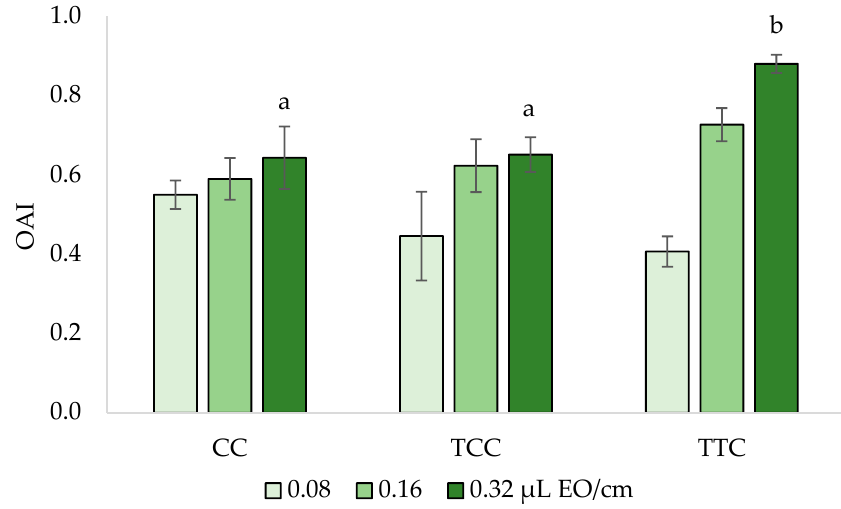
Figure 5. Oviposition deterrence against Calliphora vomitoria of the essential oils of carvacrol (CC), thymol/ p -cymene (TCC), and thymol/ γ -terpinene (TTC) oregano chemotypes. Histograms represent the mean values of the Oviposition Activity Index (OAI). Bars represent standard errors. For each concentration, different letters indicate a significant difference among EOs by Dunn–Bonferroni pairwise comparison ( p < 0.05).